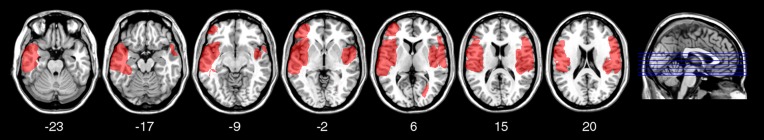
Statistical power map. Map showing the voxels (in red) where there is sufficient statistical power to detect an effect in this group of patients, overlaid on the MNI brain. In each axial slice, the left hemisphere is on the left side. Z-coordinates of each axial slice are given.